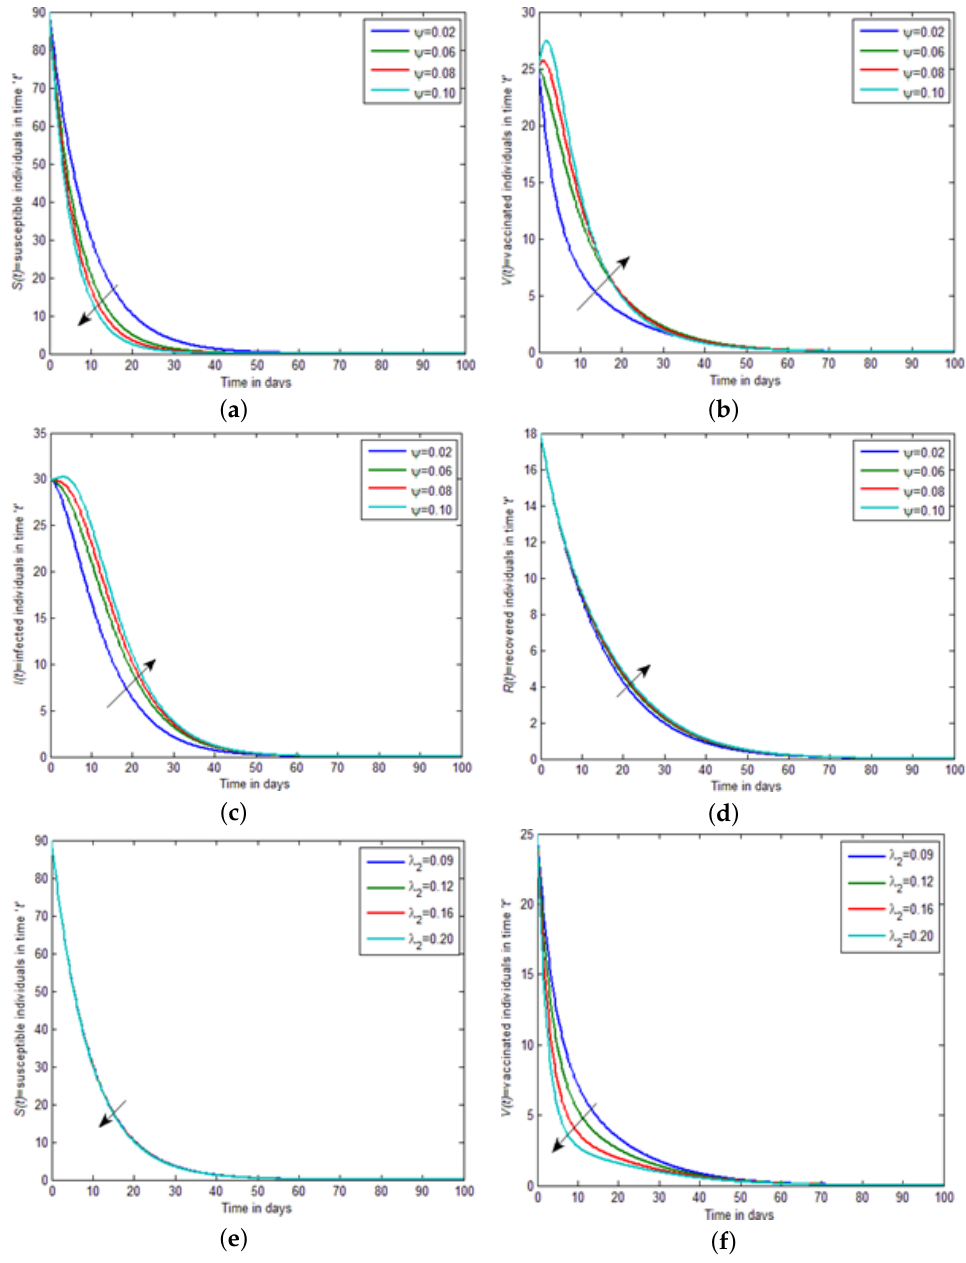
Figure 2. The population dynamics of ( a ) S ( t ) , ( b ) V ( t ) , ( c ) I ( t ) , and ( d ) R ( t ) for different values of ‘ ψ ’ and ( e ) S ( t ) , ( f ) V ( t ) , with different values of‘ λ 2